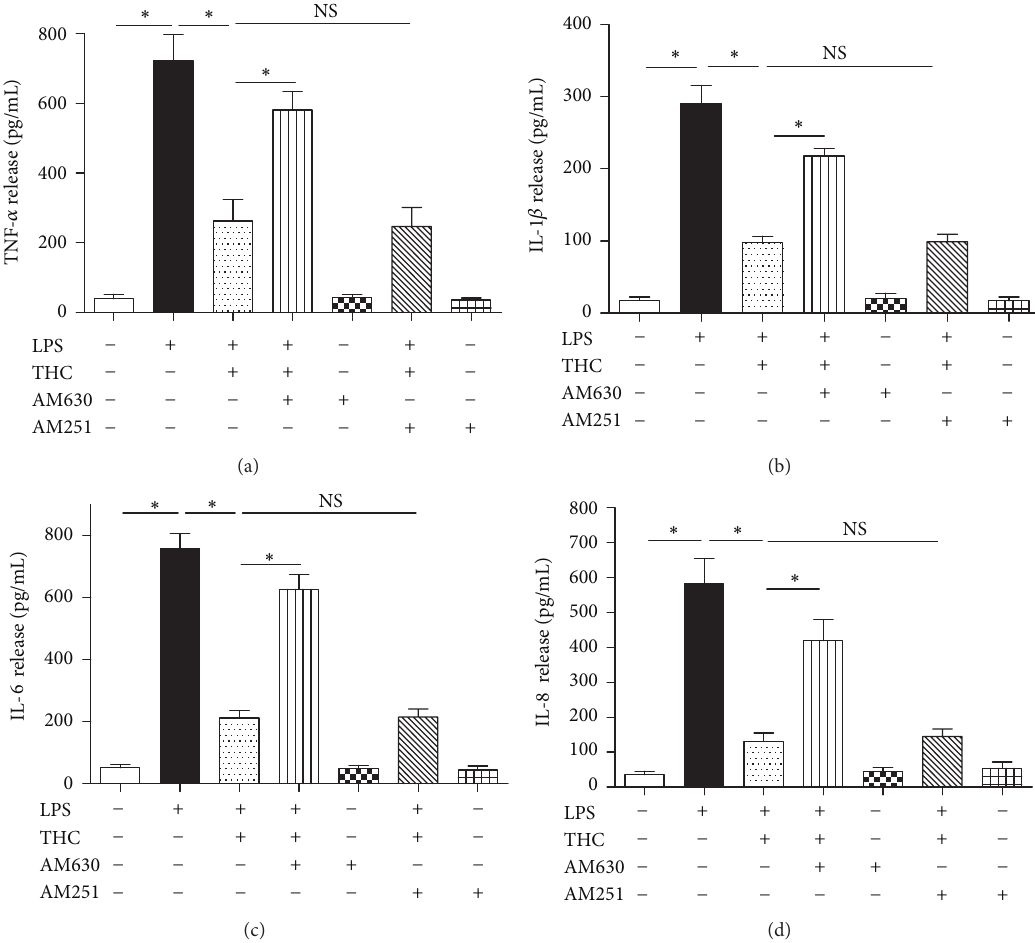
Figure 4: THC decreased the release of TNF- 𝛼 , IL-1 𝛽 , IL-6, and IL-8 from LPS-stimulated MG-63 cells. TNF- 𝛼 (a), IL-1 𝛽 (b), IL-6 (c), and IL-8 (d) release were determined by ELISA kits. THC (5 𝜇 M) decreased 10 ng/mL LPS-induced release of TNF- 𝛼 , IL-1 𝛽 , IL-6, and IL-8, and CB2 antagonist AM630 (10 𝜇 M) reversed these effects. Results are means ± SD ( 𝑛 = 6 ). ∗ : 𝑃 < 0.05 ; NS: no